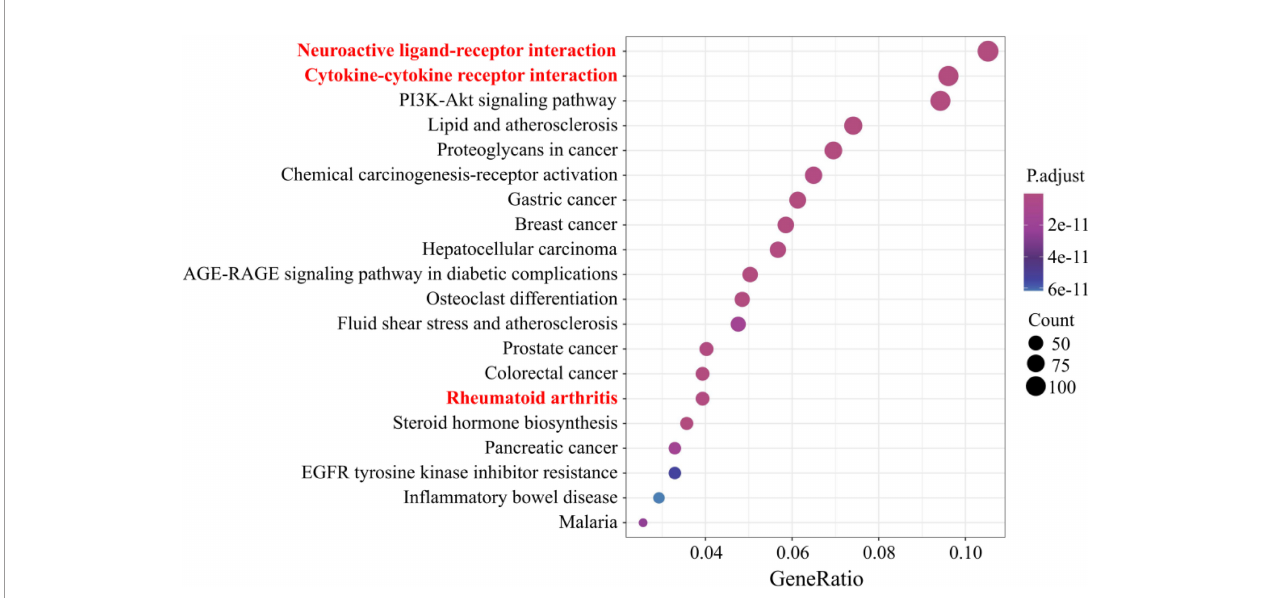
FIGURE 1 | Top 20 Kyoto Encyclopedia of Genes and Genomes (KEGG) pathway enrichment candidate targets of differential genes in postmenopausal osteoporosis. Pathways with signi fi cant changes (false discovery rate [FDR] < 0.05) were identi fi ed. The vertical coordinates represent the KEGG pathway with signi fi cant enrichment, and the horizontal coordinates represent the gene ratio, which refers to the ratio of enriched genes to all target genes. The color of the bubble graph indicates the signi fi cance of the enriched KEGG pathway, the color gradient represents the size of the P -value, and the size of each dot represents the number of